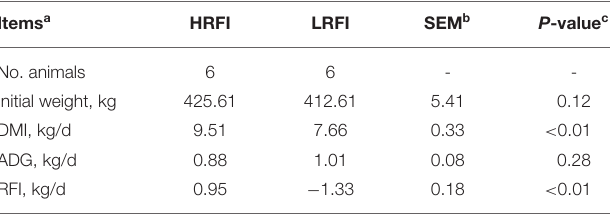
TABLE 1 | Performance of Angus heifers according to RFI